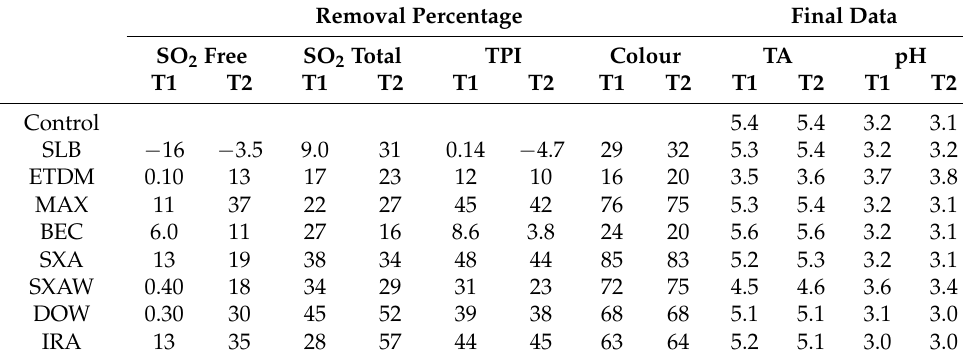
Table 6. Removal percentage of SO 2 , colour and total polyphenol index (TPI) after 24 h of treatment with resins. Total acidity, TA (g/L tartaric acid) and pH after 24 h. Removal Percentage Final Data SO 2 Free SO 2 Total TPI T1 T2